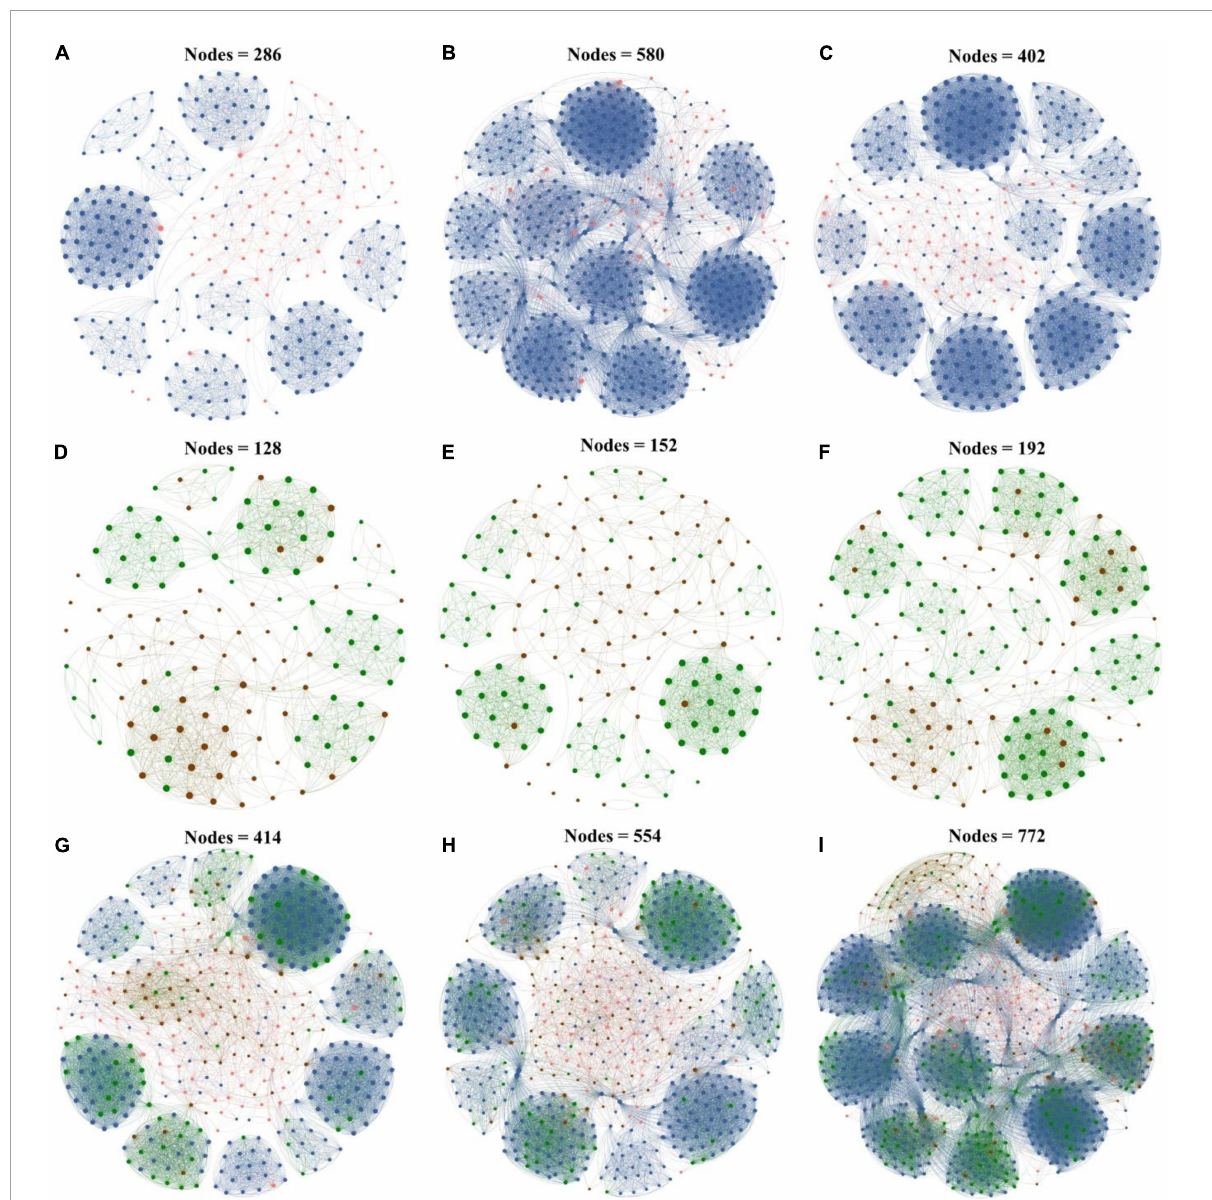
FIGURE4 Microbial networks of the control group (CK), poplar bark biochar (PB), and thiourea-modified poplar bark biochar (TP) groups. (A–C) Rare and abundant bacterial networks; (D–F) rare and abundant fungal networks; and (G–I) rare and abundant bacterial and fungal networks. The size of a node is proportional to the degree of connectivity. Blue nodes: rare bacteria; pink nodes: abundant bacteria; green nodes: rare fungi; and brown nodes: abundant